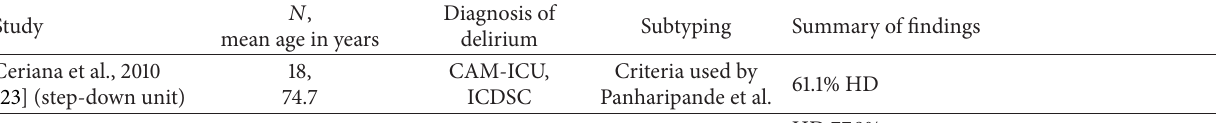
Table 1: HD in anesthesia and cardiac